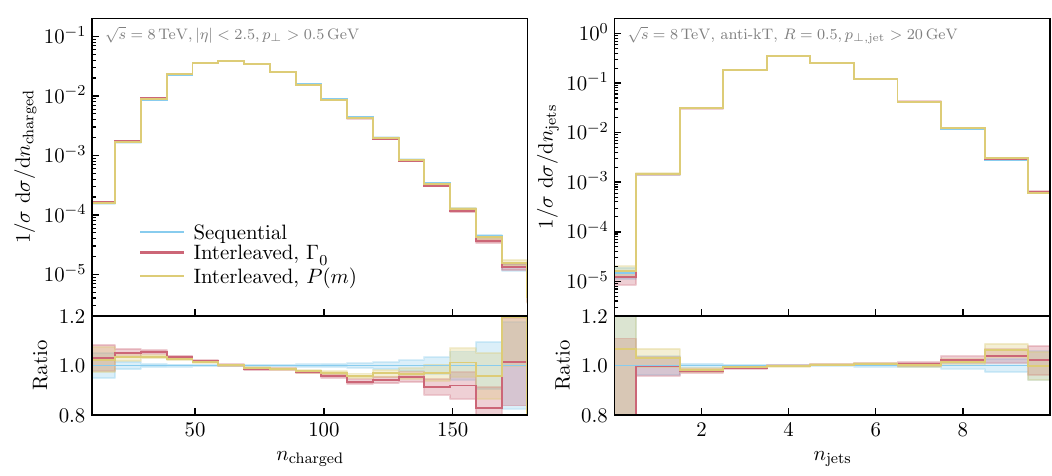
Figure 10: Multiplicity of charged particles (left) and jets (right) in semi-leptonic (cid:112) pp → t ¯ t events at s =